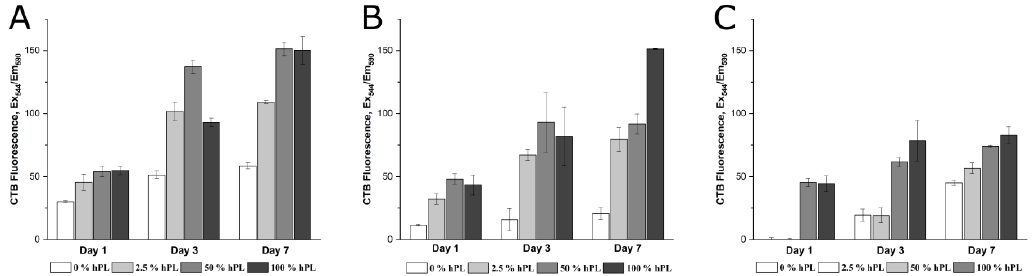
Figure 2. Cell viability of AD-MSCs encapsulated with a UV dose of 1.2 J / cm 2 in 5% (w / v) GelMA with ( A ) 50% DoF, ( B ) 70% DoF, and ( C ) 95% DoF, dissolved in 0, 2.5, 50, and 100% hPL. The CellTiter-Blue ® (CTB) assay was performed on Day 1, Day 3, and Day 7 of cultivation. Data represent the mean ± SD for a threefold determination.